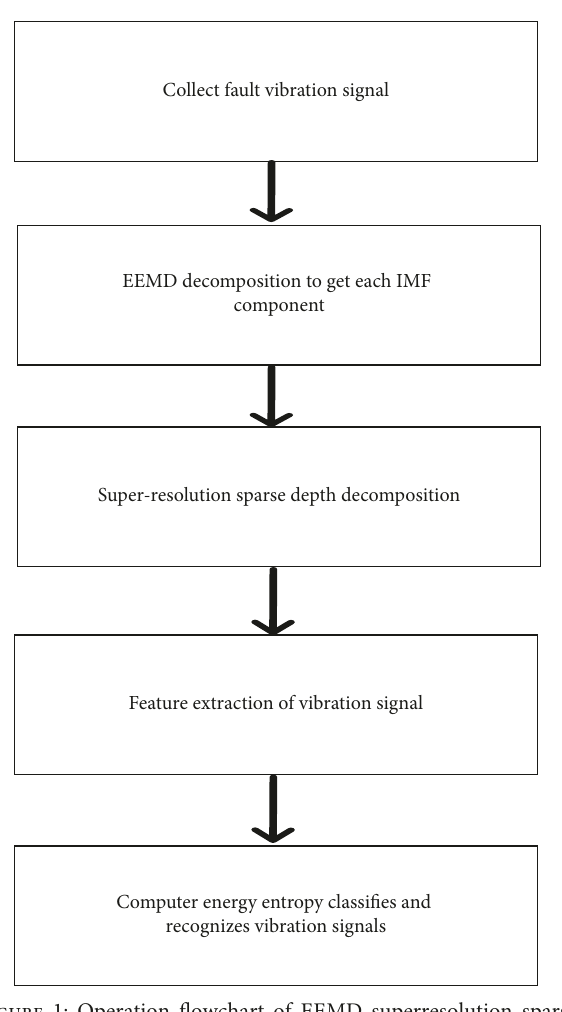
Figure 1: Operation flowchart of EEMD superresolution sparse method for fault vibration